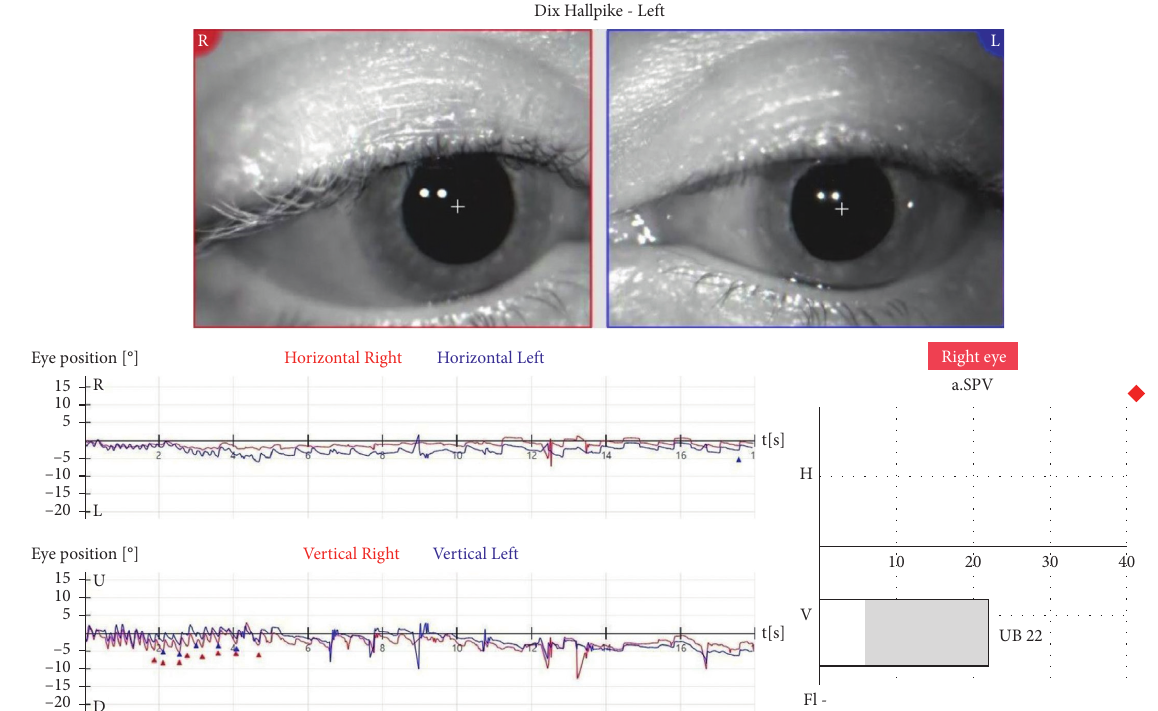
Figure 1: Left-sided Dix–Hallpike test performed during the initial videonystagmography (VNG) recorded upbeat nystagmus, of SPV 22 °